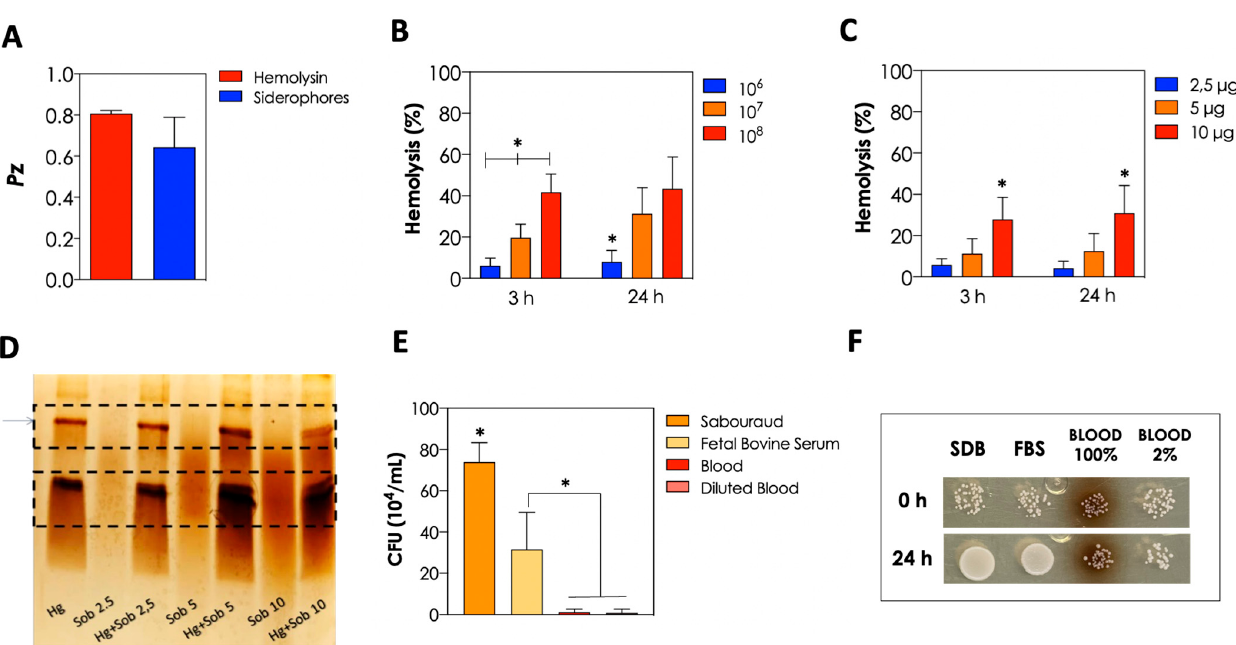
Figure 3. Extracellular molecules produced by S. cerevisiae HUPE-Sc1 strain by means of agar plates containing specific substrates to detect hemolysin and siderophores ( A ). Lysis of fresh erythrocytes after 3 h and 24 h of incubation at 37 °C by different inocula of S. cerevisiae HUPE-Sc1 strain (10 6 , 10 7 and 10 8 cells) ( B ) and different protein amounts of the cell-free culture supernatant in Sabouraud ( C ). SDS-PAGE demonstrating the hydrolysis of hemoglobin (Hg) by the enzymes present in the culture supernatant (Sob) of HUPE-Sc1 strain (2.5, 5 and 10 µg of proteins); the dashed boxes highlight intact hemoglobin (upper box) and hydrolyzed hemoglobin (lower box) ( D ). HUPE-Sc1 strain growth capacity in different nutrient sources (Sabouraud, FBS, blood [100%] and diluted blood [2%]) after incubation of 10 4 yeasts/mL at 37 °C for 24 h as demonstrated by CFU counts ( E ) and by spot inoculum of 10 µL of each system on SDA ( F ). The results represent means ± standard deviation of three independent experiments. The symbol (*) indicates p values < 0.05 (one-way ANOVA, Tukey’s multiple comparison).